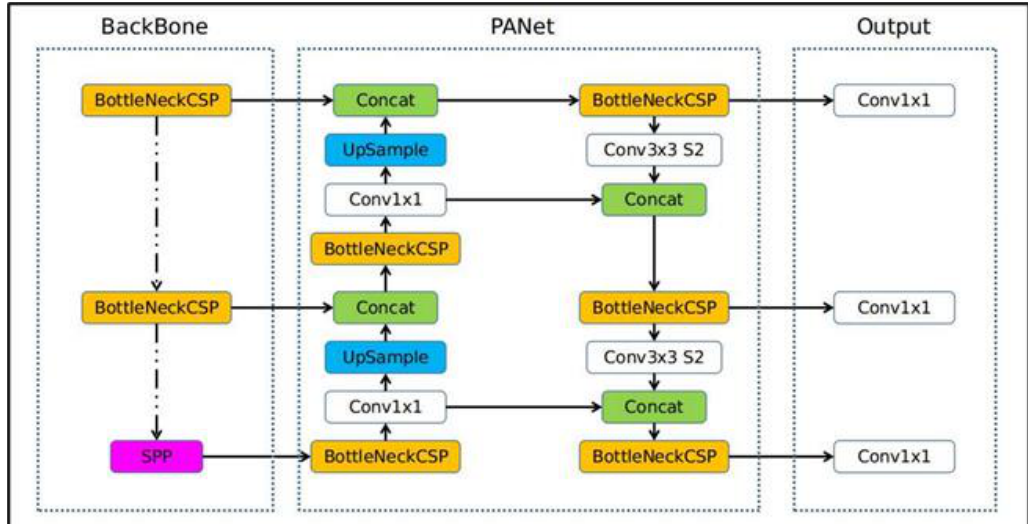
Figure 2. YOLOv5 network structure [39].